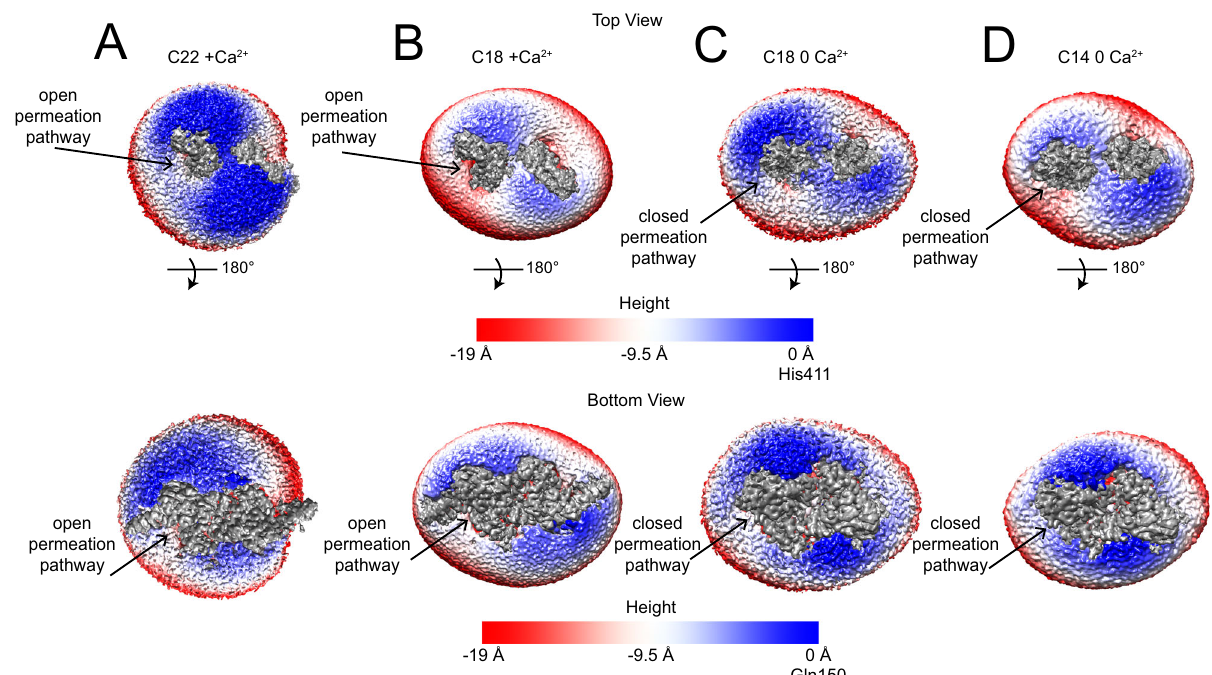
Fig. 6 Membrane thinning at the afTMEM16 pathway as a function of acyl chain length. Views of the density maps for afTEM16 in C22/Ca 2 + ( A ), C18/ Ca 2 + ( B ), C18/0 Ca 2 + ( C ) and C14/0 Ca 2 + ( D ) from the extracellular (top panels) and intracellular (bottom panel) side. The C1 fi nal unsharpened maps containing nanodisc densities were aligned, resampled on the same grid, and colored according to the Z coordinate using UCSF Chimera. The density corresponding to the protein is segmented and shown in gray. Nanodisc densities are colored by displacement along the Z axis and the 0 Å reference height for the top views corresponds to H411 in the helix connecting TM5 and TM6, and Q150 on the hairpin preceding TM1 and TM2 for the bottom views. Negative values represent membrane thinning relative to the overall nanodisc. The position of the permeation pathway is denoted with arrows.